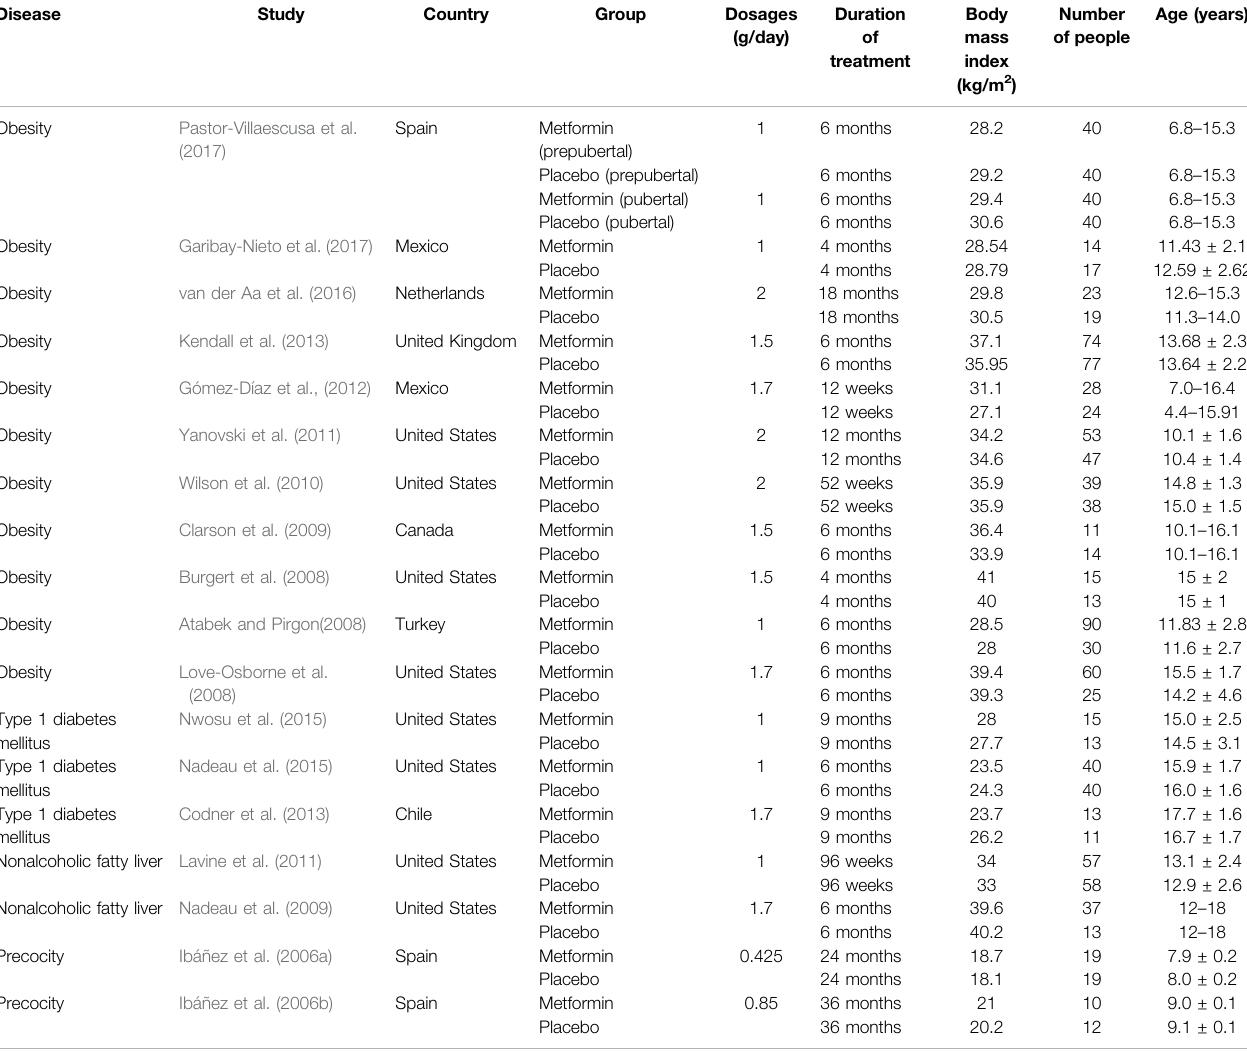
TABLE 1 | Studies identi fi ed for analysis.